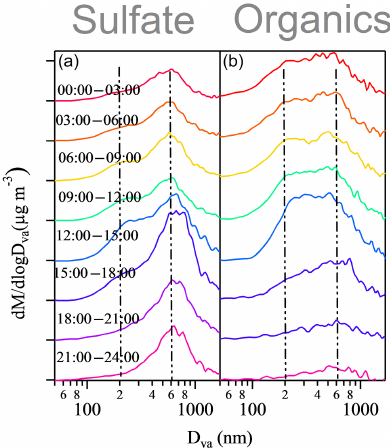
Figure 8. Size distributions of sulfate (a) and organics (b) in differ- ent time intervals during E4.